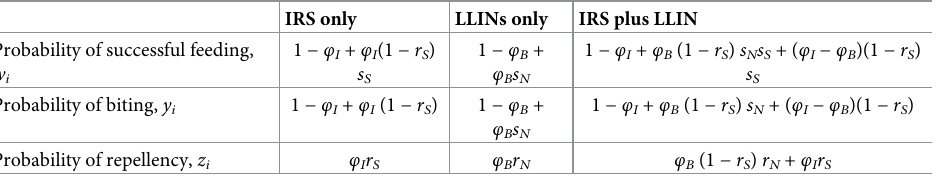
Table 3. Vector control probability matrix courtesy of Griffin et al. [22]. IRS only LLINs only IRS plus LLIN Probability of successful